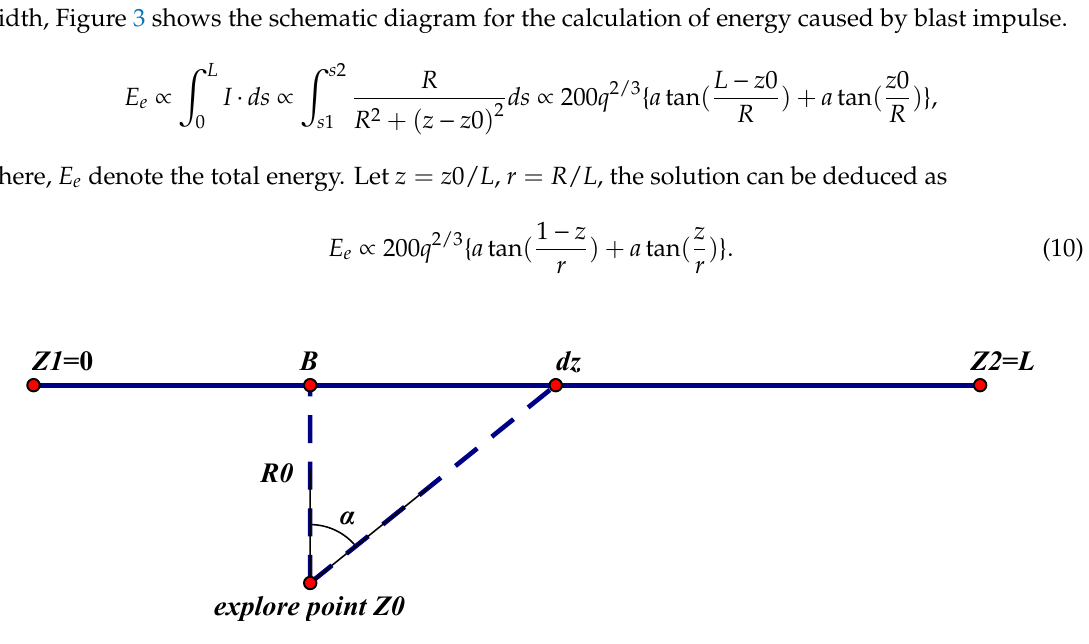
Figure 3. The calculation sketch of energy when detonation is in the middle along the width.